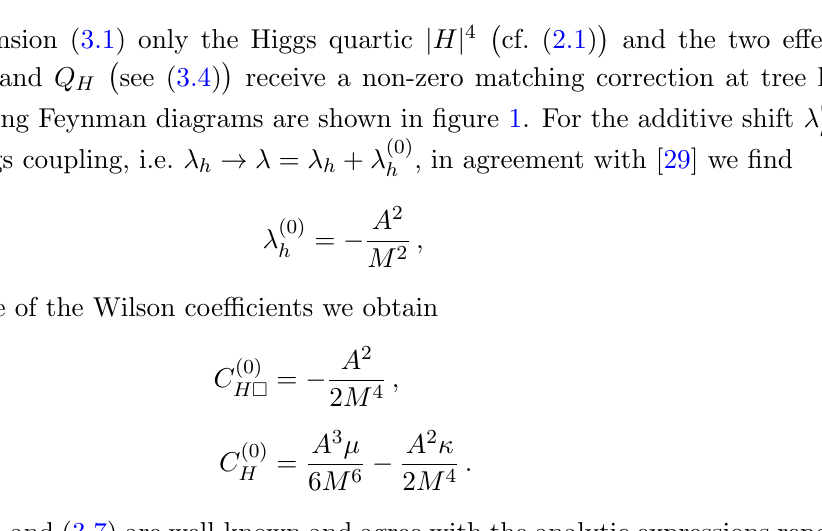
Figure 1 . Example diagrams that contribute to the tree-level matching coe(cid:14)cients (cid:21) (0) C (0) (left) and C (0) (right), respectively. Double-dashed lines represent virtual exchange of the H H (cid:3) heavy real singlet scalar (cid:12)eld (cid:30) , while single-dashed lines stand for H or H y